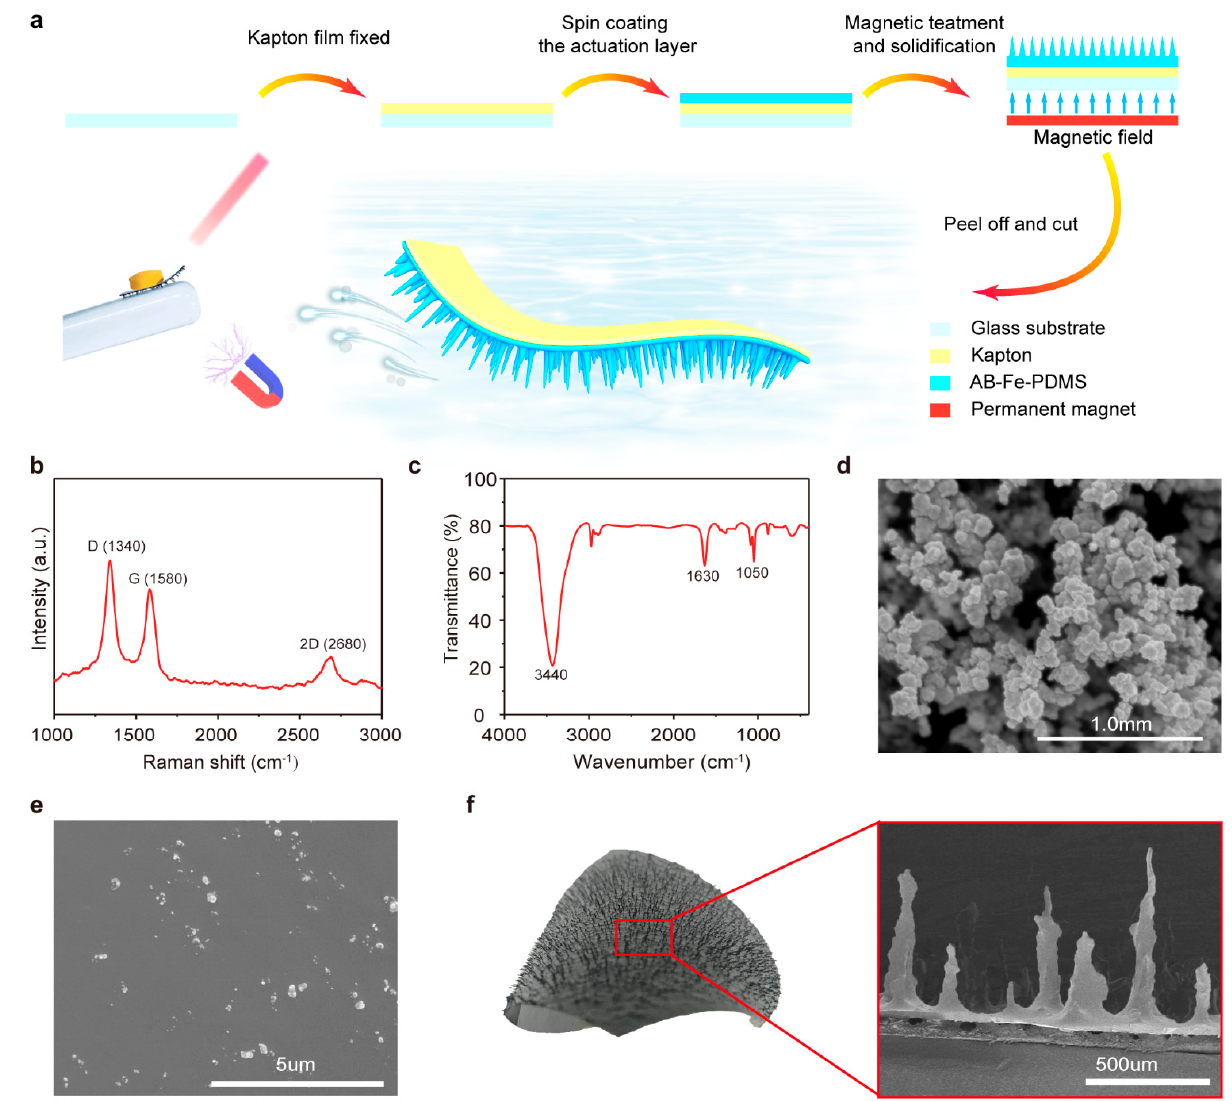
Figure 1. ( a ) Schematic illustration of the synthesis process of the polymeric bilayer actuator and millirobot. ( b ) Raman spectrum of the acetylene black (AB) microparticles. ( c ) Fourier-transform infrared (FTIR) spectrum of AB. ( d ) Scanning electron microscope (SEM) images of acetylene black (AB). ( e ) Cross-section SEM image of the AB/polydimethylsiloxane (PDMS) layer. ( f ) SEM lateral view of the multi-legged structure, showing the irregular tapered architecture of the milli-legs.